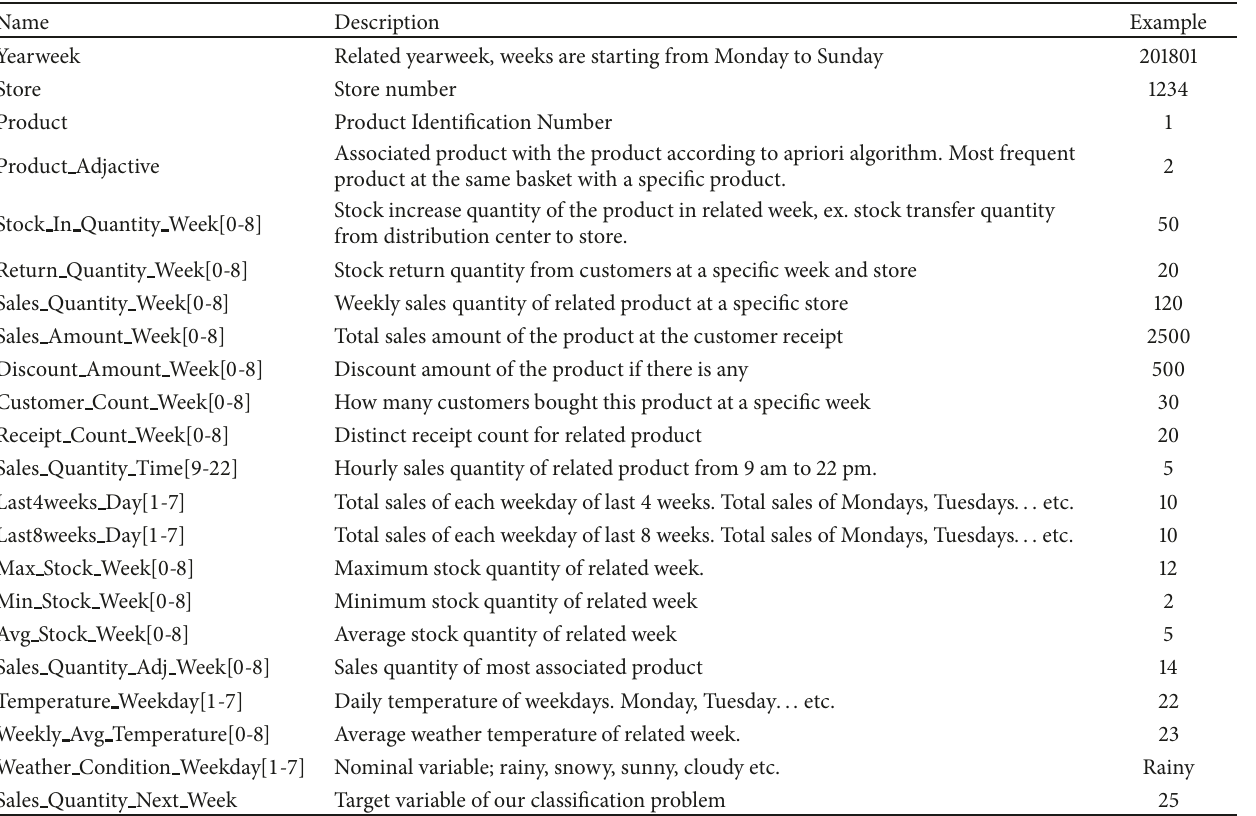
Table 2: Dataset